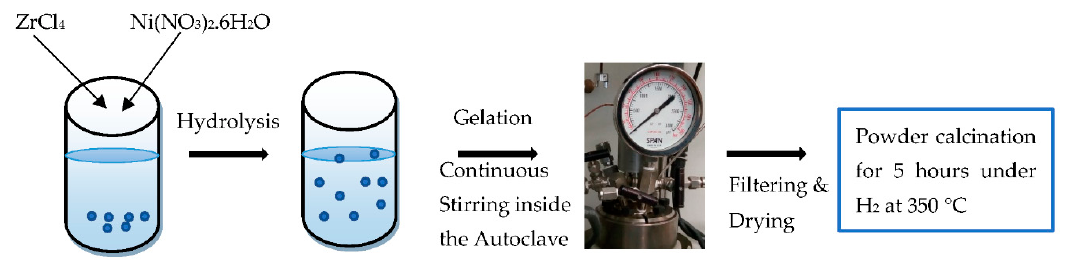
Figure 11. The steps of synthesis of the catalyst preparation.